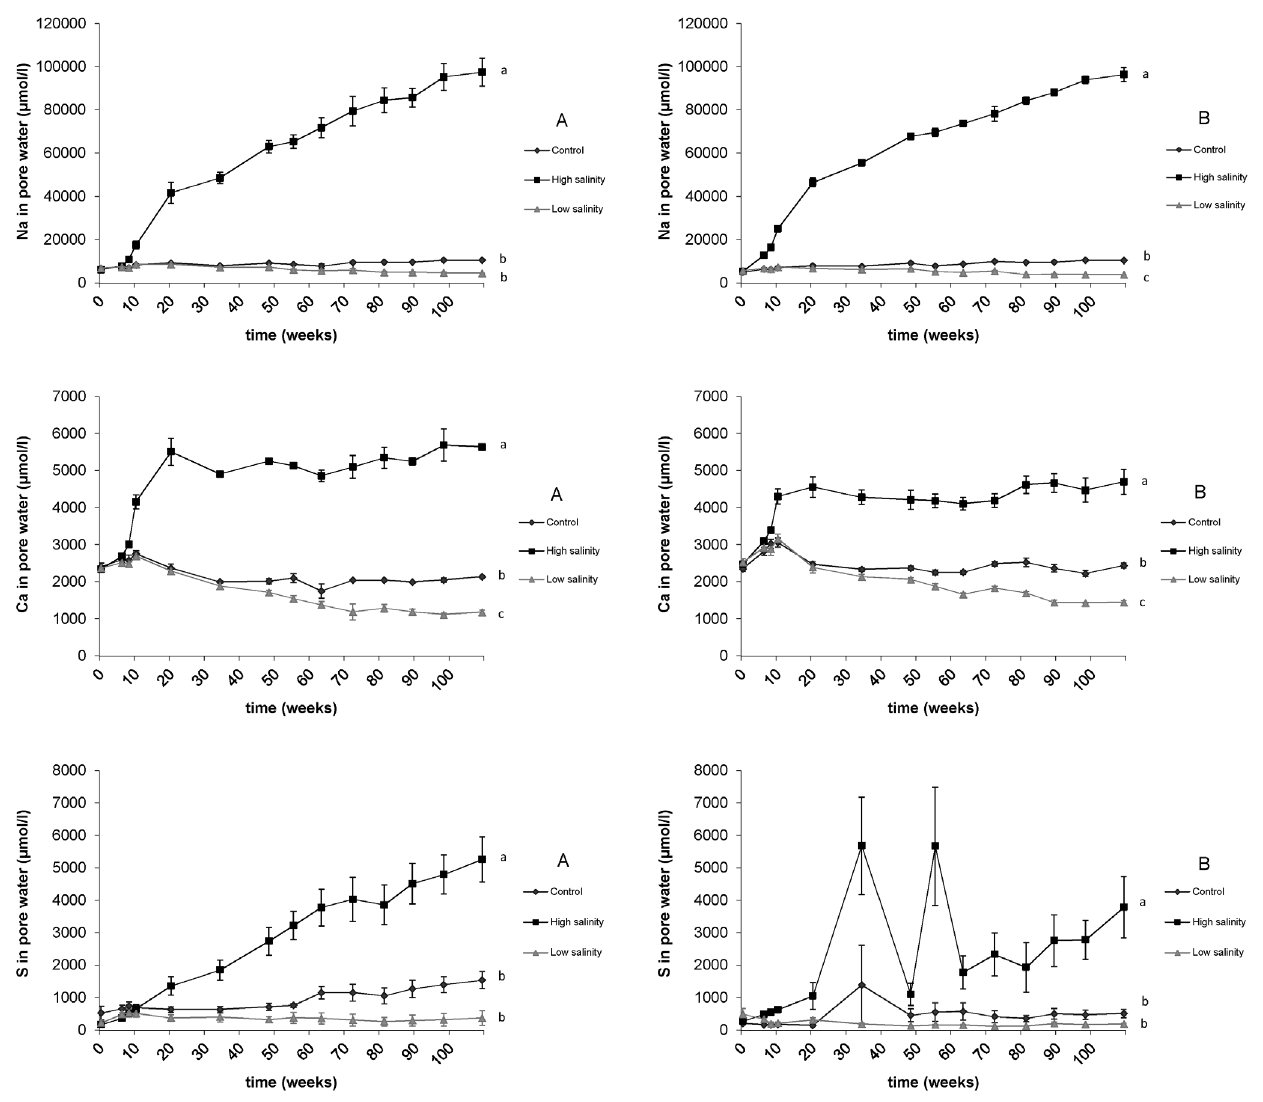
Figure 1. Sodium (Na + ), calcium (Ca 2 + ) and sulphur (S) pore water concentrations ( m mol L 2 1 ) in both sediments (A: left, B: right). Significant differences between treatments are indicated with different letters.